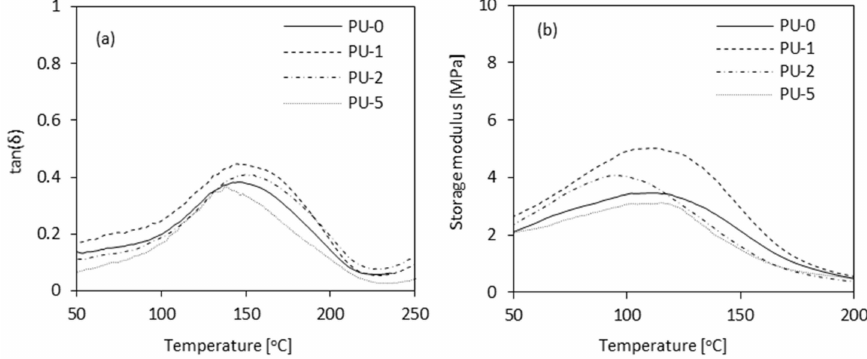
Figure 10. Dynamic mechanical analysis of PU composite foams—( a ) Tan δ and ( b ) storage modulus as a function of temperature.